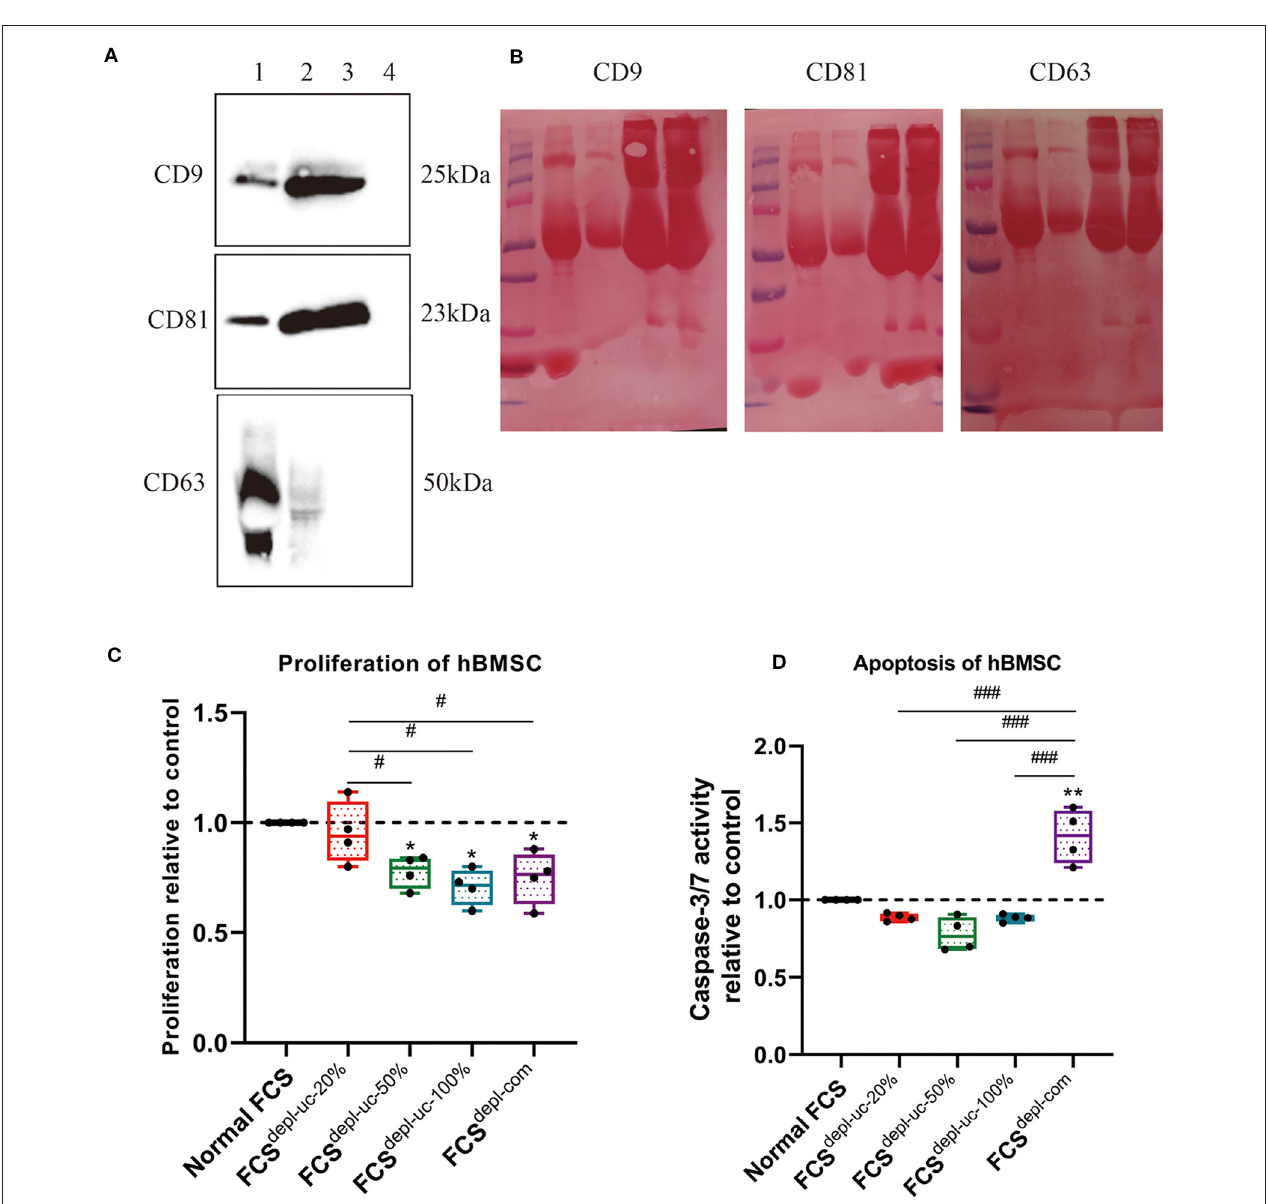
FIGURE 3 | Characterization of EV-depleted FCS (FCS depl-uc ). Prior to ultracentrifugation, normal FCS was diluted in culture medium to different concentrations (20, 50%, and undiluted = 100%); different FCS depl-uc groups were identified after ultracentrifugation. (A,B) FCS depl-uc-20 % was controlled for EV surface makers (CD9, CD63, and CD81) detected by western blotting (lane 1: hBMSC lysate; lane 2: hBMSC-EVs; lane 3: undepleted FCS; lane 4: FCS depl-uc-20 % ). Representative western blot image (A) and Ponceau Red-stained images for each surface marker (B) are shown; n = 3. (C,D) Proliferation and apoptosis of hBMSC were determined by BrdU assay and caspase-3/7 activity assay separately after being incubated in culture medium supplemented with the different FCS groups for 24h. All values represent mean ± standard deviation. *Significant difference to control: * p < 0.05; ** p < 0.01; # Significant difference between groups: # p < 0.05; ### p < 0.001 one-way ANOVA with Newman–Keuls Multiple Comparison Test; n =